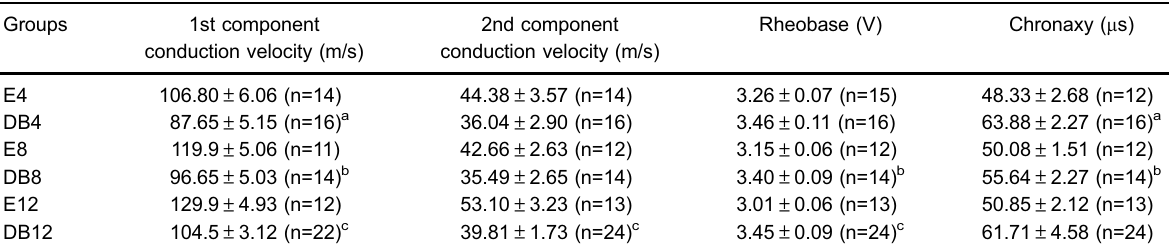
Table 2. Excitability and electrical properties of euglycemic groups (E4, E8, and E12) and diabetic (DB4, DB8, and DB12) groups at 4, 8, and 12 weeks.